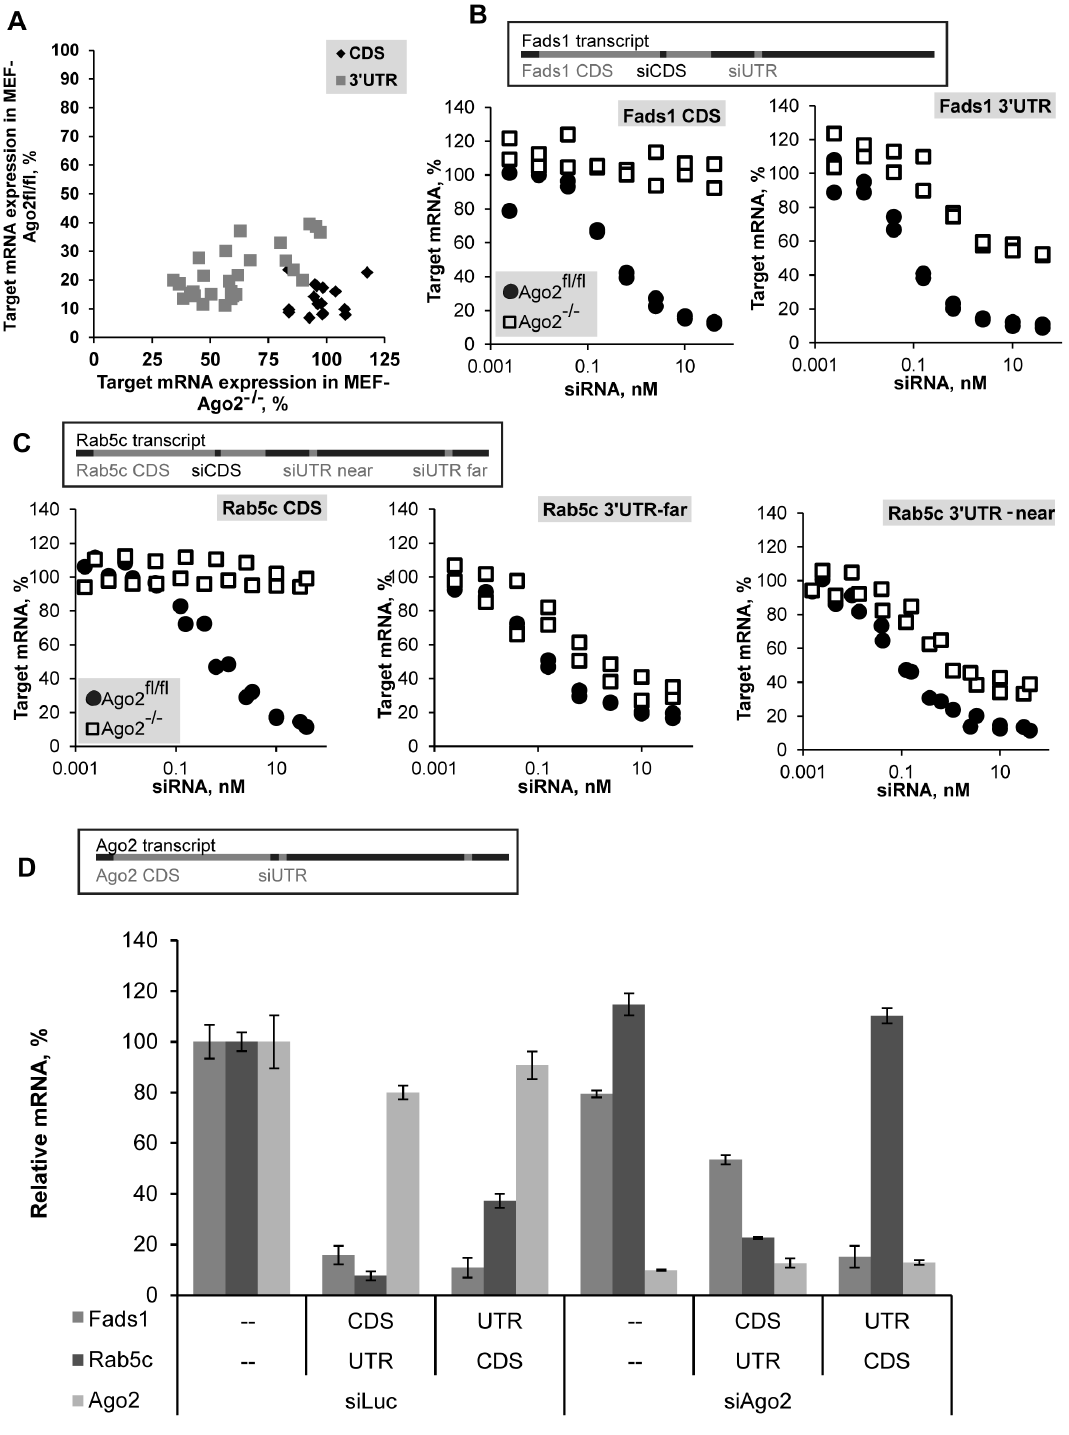
Figure 1. Differential Ago2 dependence of siRNAs targeting coding sequence (CDS) and 3 9 -untranslated region (3 9 UTR) of mRNA invitro . (A) Mouse embryonic fibroblast (MEF) cells, Ago2 fl/fl and Ago2 2 / 2 (wild-type and Ago2 knockout) were transfected with 10 nM of siRNAs targeting CDS or 3 9 UTR (16 or 28 siRNAs, respectively, Table S1) of mRNAs of four genes: Fads1, Fads2, Rab5a, and Rab5c. Levels of expression of target-gene mRNA in Ago2 fl/fl MEF cells and Ago2 2 / 2 MEF cells measured by branched DNA (bDNA) assay 24 h post-transfection were plotted as percentage of relative target mRNA compared to Luciferase siRNA transfected controls. (B, C) Ago2 2 / 2 MEF cells (square) or Ago2 fl/fl MEF cells (circle) were transfected with siRNAs targeting CDS or 3 9 UTR of Fads1 (B) or Rab5c (C) mRNA (relative positions of target sites within mRNA are shown). Transfection and assay as described in A, but dilution series with the maximum dose of 40 nM were done. Combined results of two independent transfections are shown. (D) Ago2 fl/fl MEF cells were transfected with 10 nM siRNA targeting 3 9 UTR of Ago2 (Eif2c2) mRNA or Luciferase, followed by transfection with two combinations of siRNAs targeting Fads1 and Rab5c (CDS-targeting for one gene and 3 9 UTR-targeting for the other gene, 10 nM each, or 20 nM of Luciferase siRNA control) 48 hours later. Levels of target-genes and Ago2 mRNA expression measured by bDNA assay 24 h after